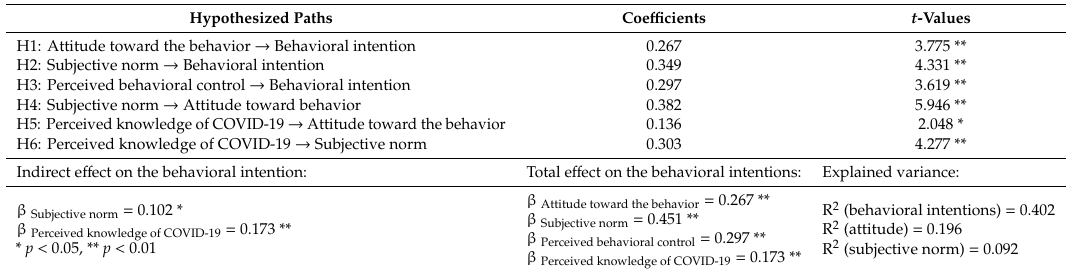
Table 2. Results of the structural equation modeling ( n = 305).